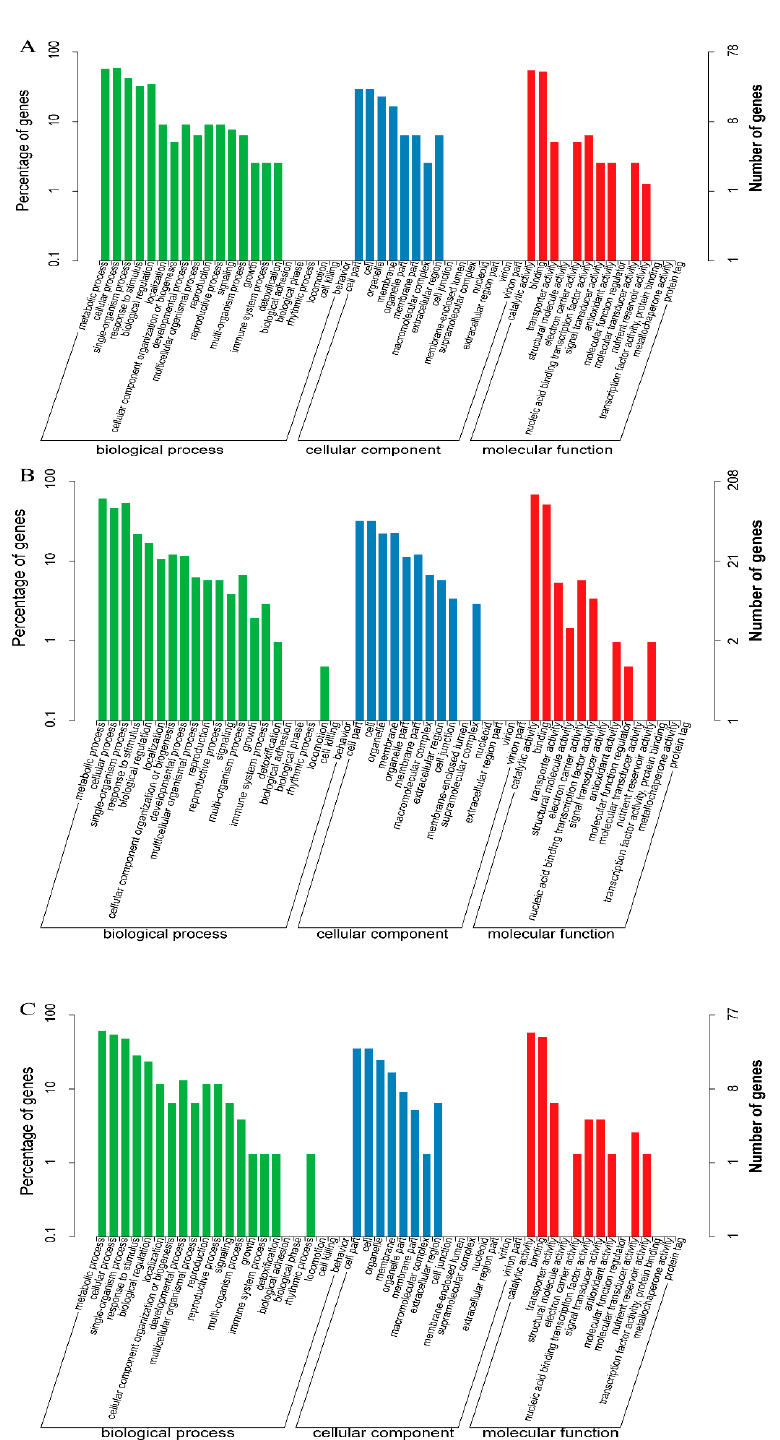
Figure 5. Gene Ontology (GO) enrichment analysis in pairwise comparisons. ( A ) GO enrichment analysis in W vs. UV-A. ( B ) GO enrichment analysis in W vs. UV-B. ( C ) GO enrichment analysis in W vs. UV-AB.